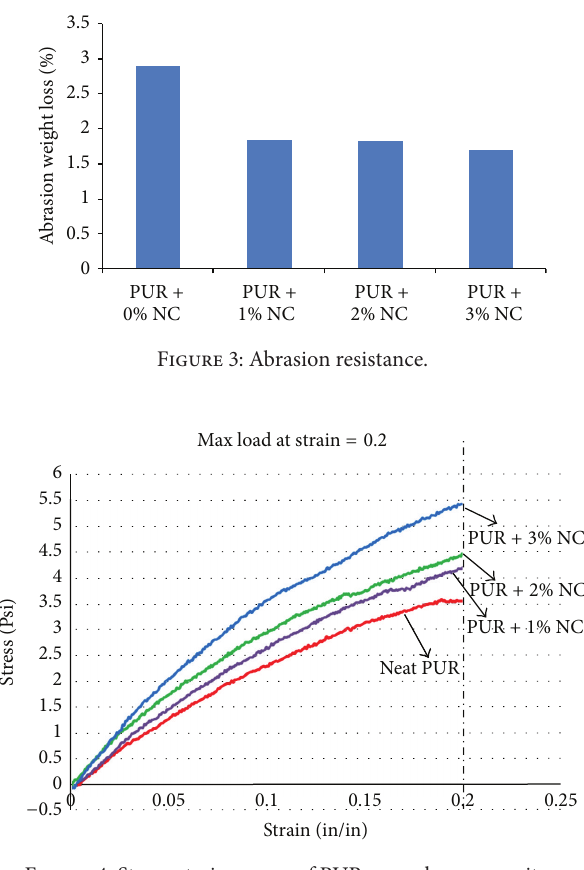
Figure 4: Stress-strain curves of PUR-nanoclay composites.